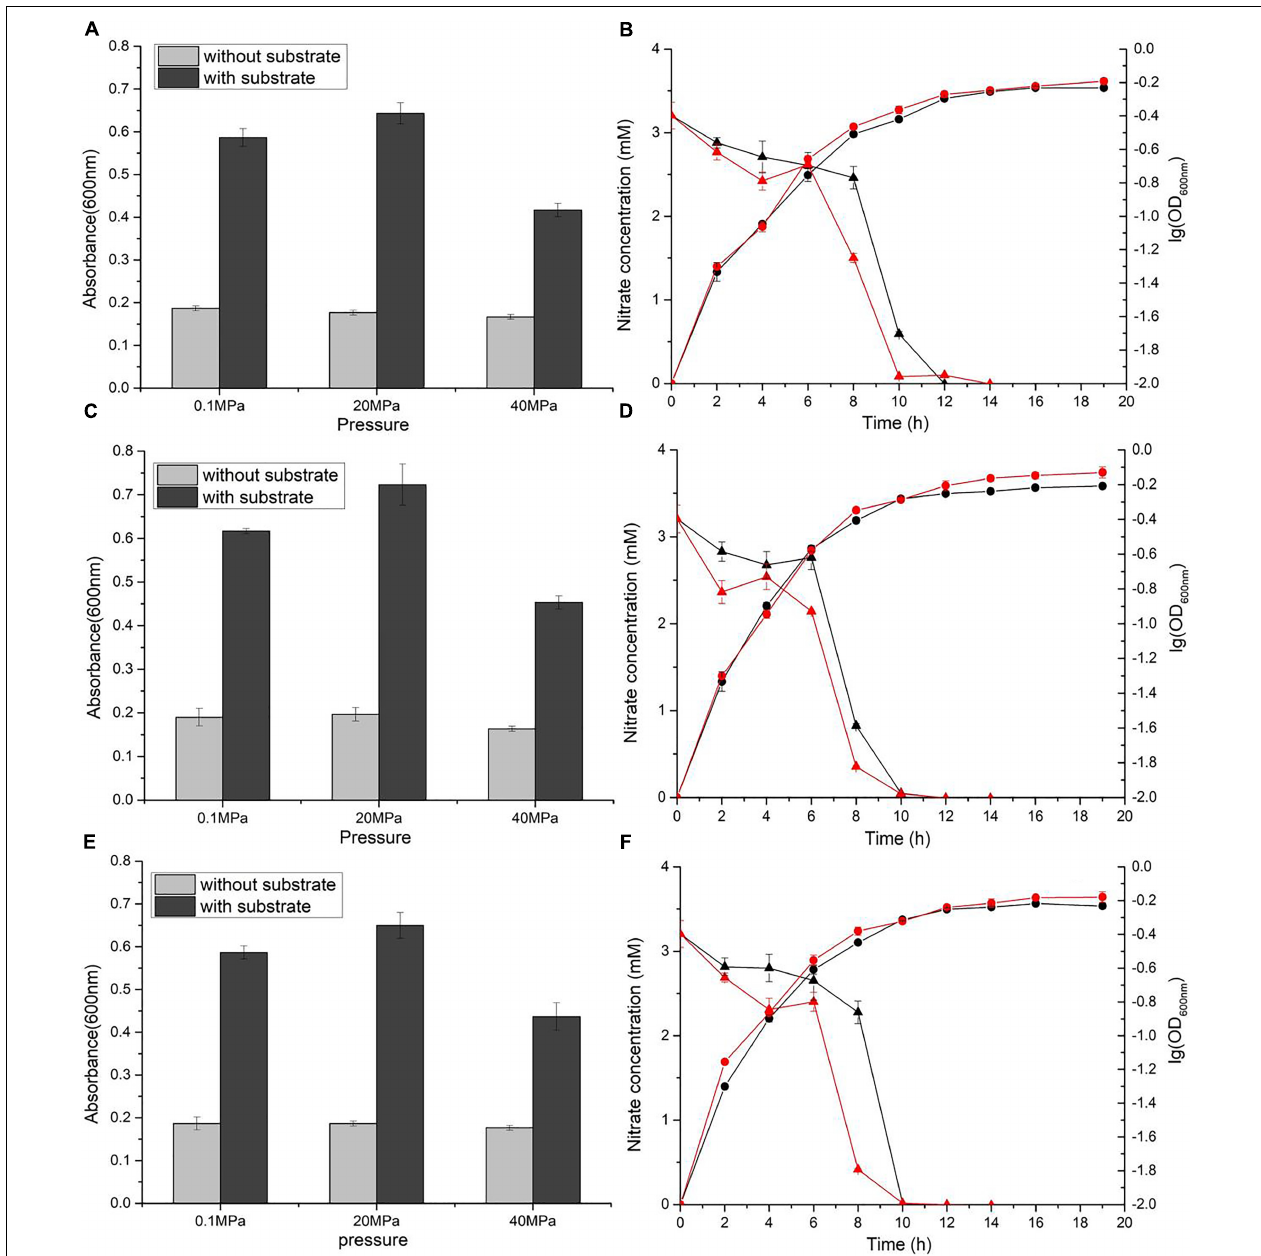
FIGURE 1 | Nitrate sustained growth of WP3 and (cid:49) napA mutants under different pressures. Final biomass of WP3 (A) , WP3- α (C) and WP3- β (E) cultivated in 2216E media with or without substrate (nitrate plus lactate) at different pressure conditions. Growth curve and nitrate consumption curve of WP3 (B) , WP3- α (D) and WP3- β (F) at 0.1 and 20 MPa. Each value was the average of three measurements. • : cell density at 0.1 MPa; • : cell density at 20 MPa; (cid:78) : nitrate concentration of the supernatant at 0.1 MPa; and (cid:78) : nitrate concentration of the supernatant at 20 MPa.